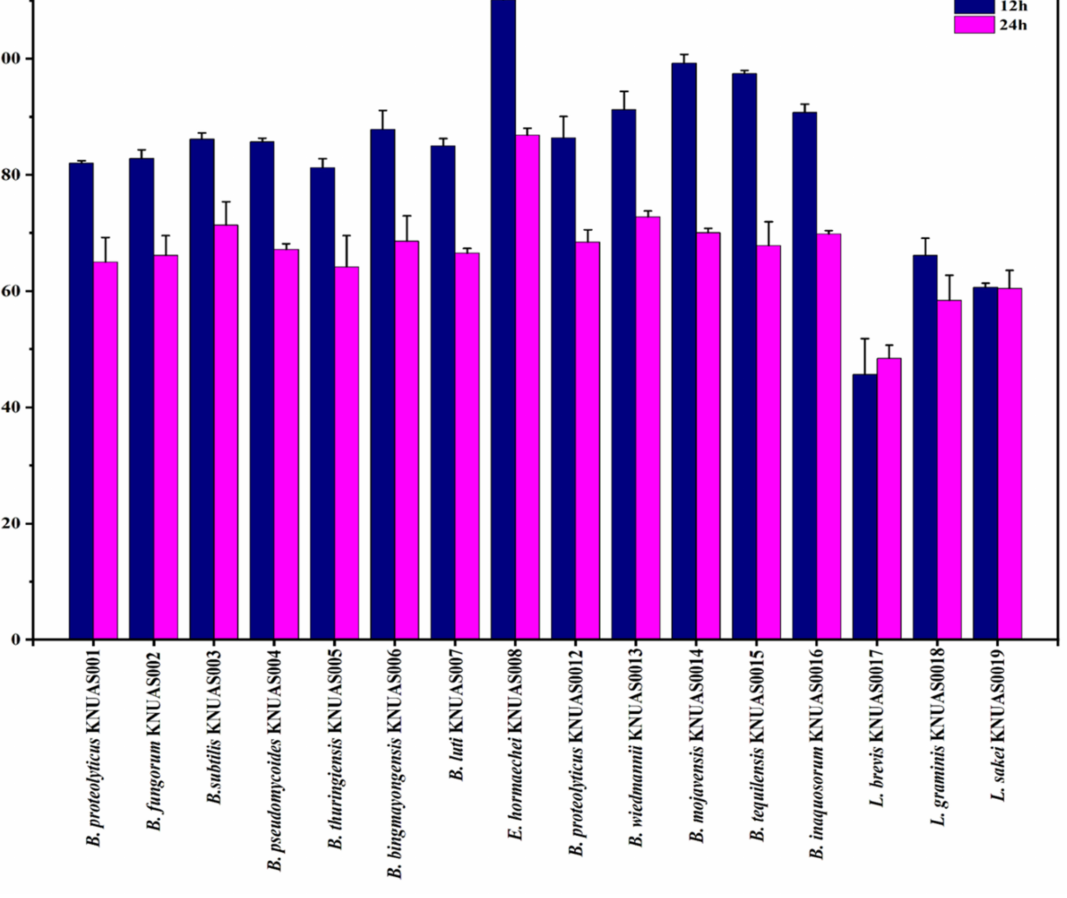
Figure 4. Antibacterial activity of cell-free supernatant of isolated bacterial strains against Staphylococus aureus ( S. aureus